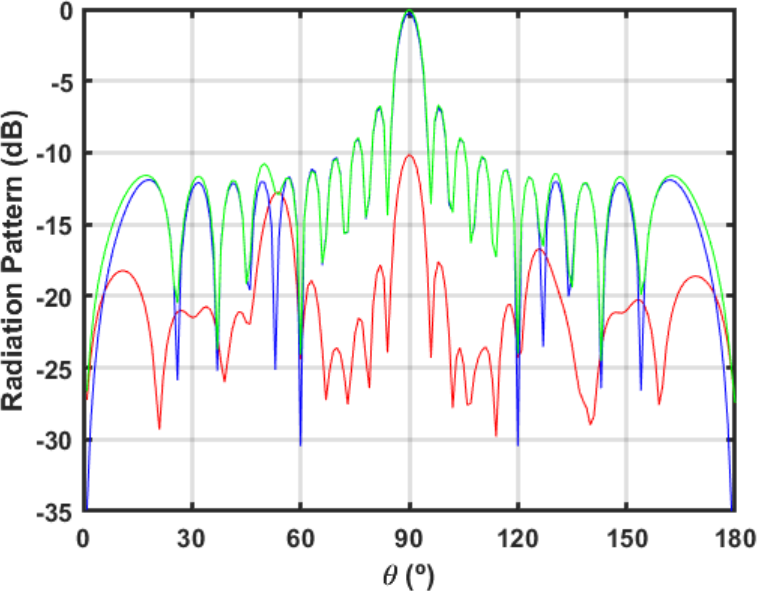
Figure 19. Radiation Pattern (RP) of RACD with 20 antennas case Table 2-(2) step = 0.11 m: (---) RP without helix. (---) Parasitic RP of helix. (---) Total RP.